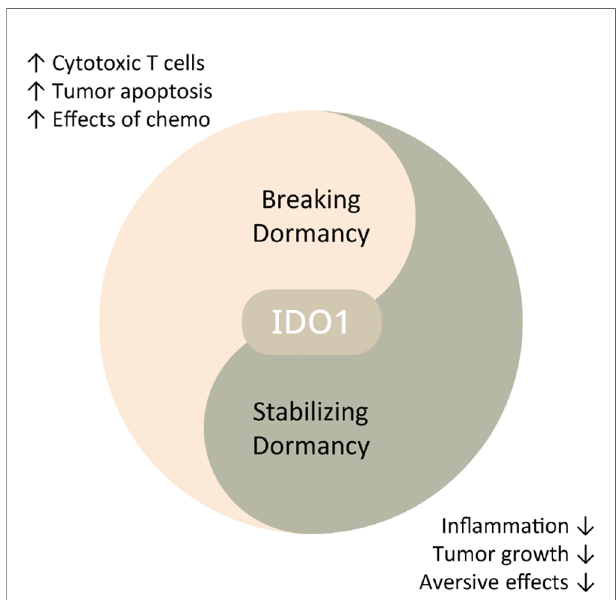
FIGURE 3 | Schematic diagram displaying potential therapeutic strategies against cancers through IDO1 regulation. IDO1 inhibition may break dormancy, thereby promoting immune surveillance and enhancing other anti- cancer therapies. Low-dose IDO1 suppression can induce dormancy, alleviating tumour growth and tumour-related aversive